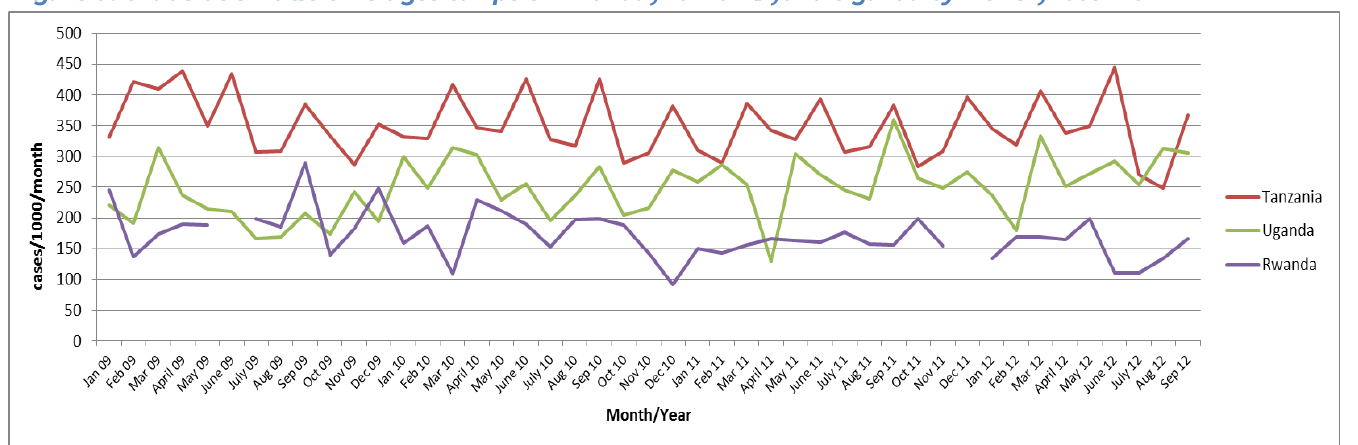
Figure 6: Crude birth rates in refugee camps in Rwanda, Tanzania, and Uganda by month, 2009 – 2012